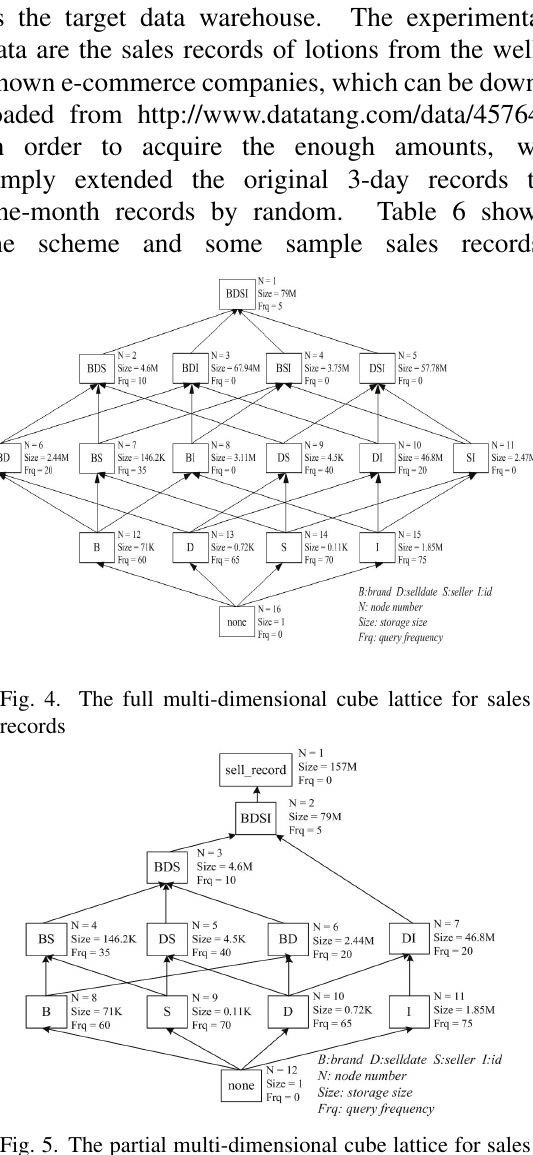
Fig. 5. The partial multi-dimensional cube lattice for sales